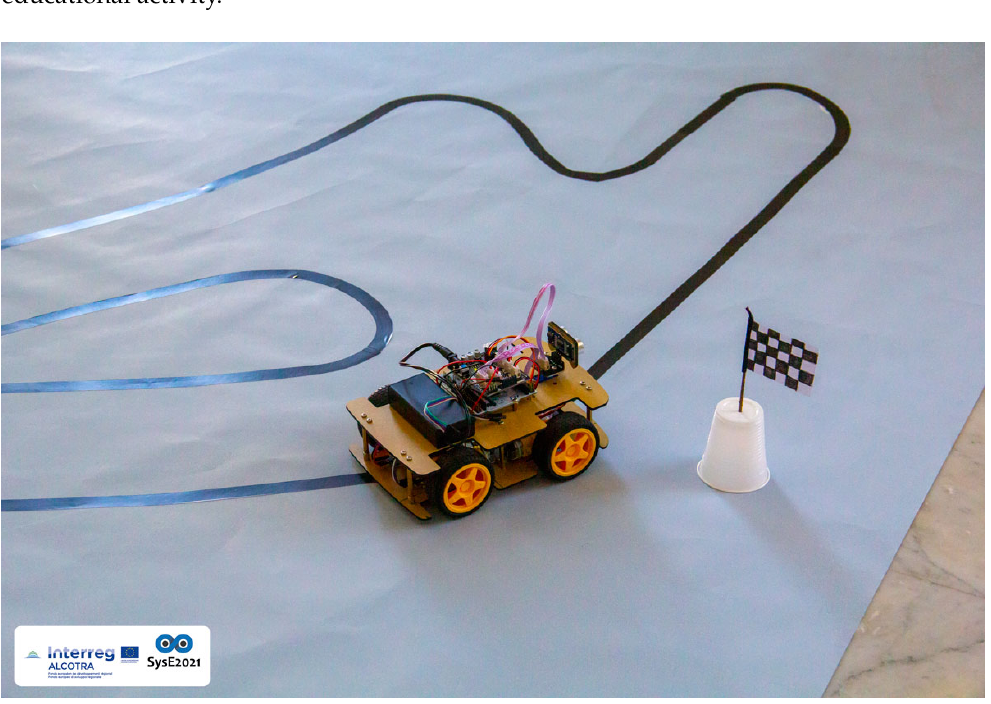
Figure 9. Trial during the Summer School